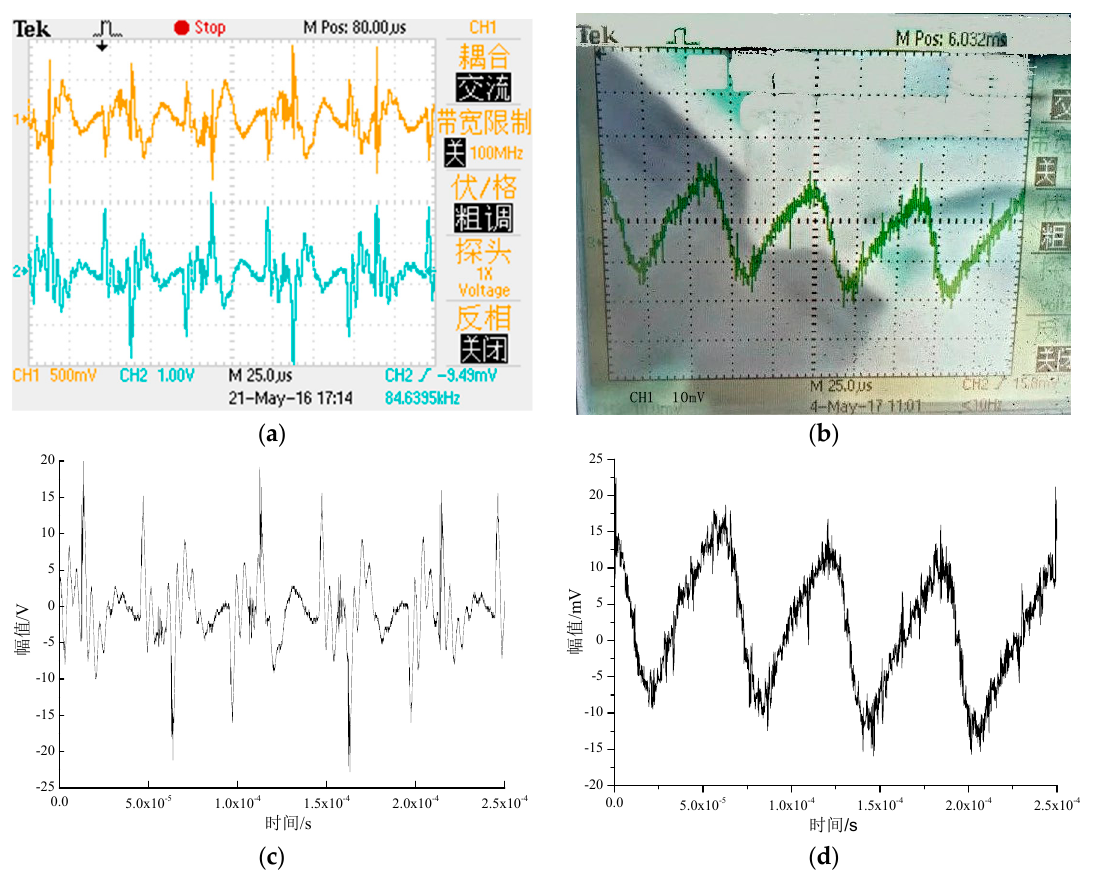
Figure 3. The time-domain waveform of the measured PV array noise. ( a ) The measured noise which is observed from the oscillograph for experimental platform 1; ( b ) The measured noise which is observed from oscillograph in experimental platform 2; ( c ) The measured noise in experimental platform 1; ( d ) The measured noise in experimental platform 2.